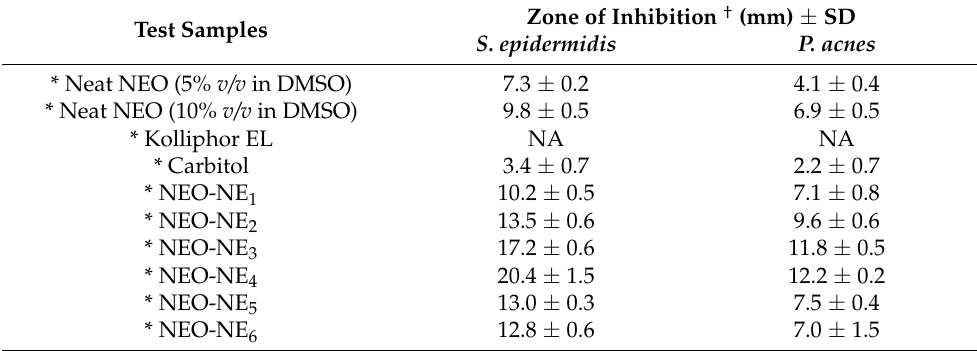
Table 6. Antiacne assay of NEO-NEs. Test